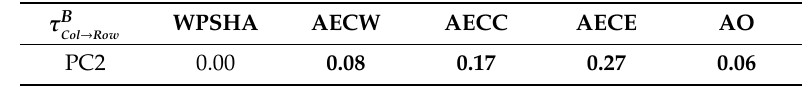
Table 9. IF τ B values between PC2 and the Atmospheric circulation-indices based predictors Col → Row (bold font indicates statistically significant values at the 5% level).